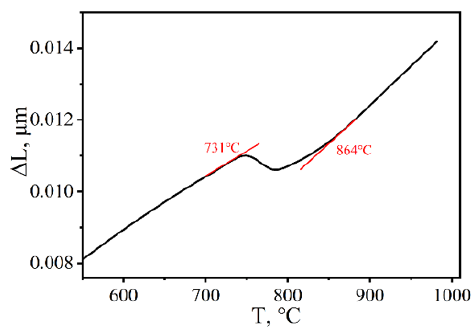
Figure 1. Thermal expansion curve.